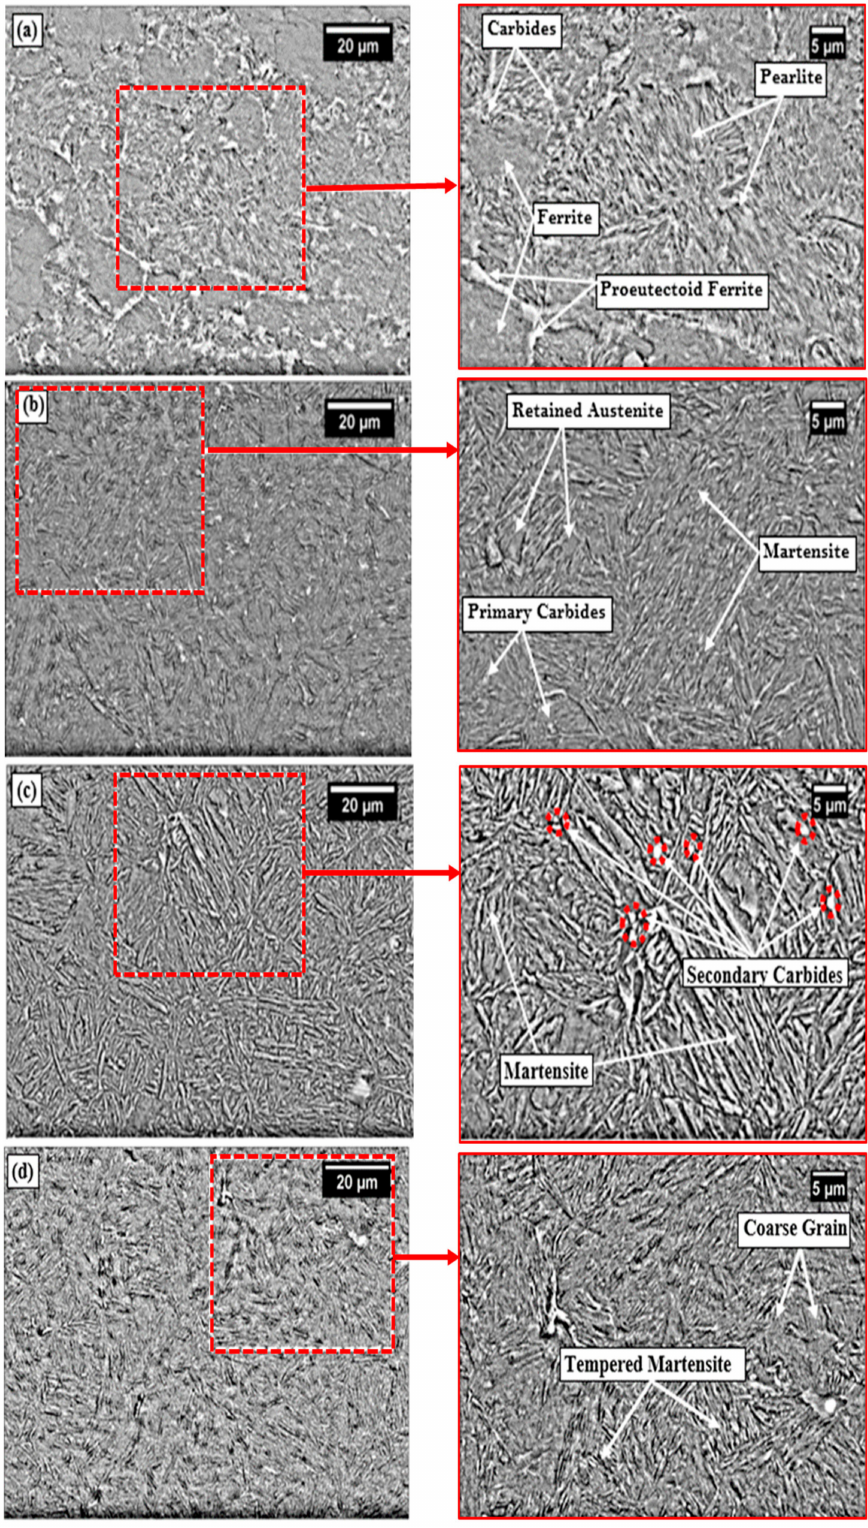
Figure 6. SEM microstructures of ( a ) untreated, ( b ) conventional heat-treated (900 ◦ C / 0.67 h, water-quenched), ( c ) conventional heat-treated (900 ◦ C / 0.67 h, water-quenched) + deep cryogenic treatment ( − 185 ◦ C / 12 h), and ( d ) conventional heat-treated (900 ◦ C / 0.67 h, water-quenched) + deep cryogenic treatment ( − 185 ◦ C / 12 h) + tempering (200 ◦ C / 1 h,